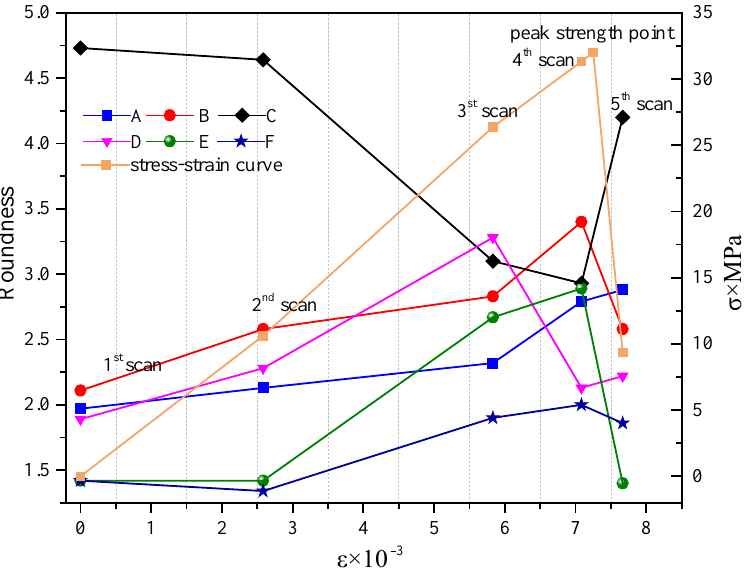
Figure 12. Variation on the roundness of each hole with the loading.